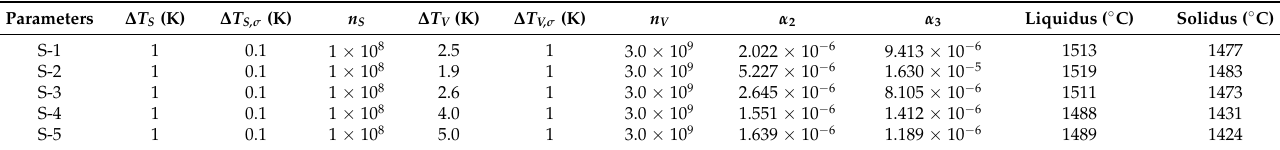
Table 2. Nucleation parameters of CAFE